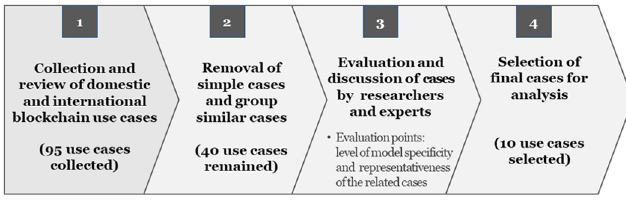
Fig 1. The procedure of selection of blockchain-applied use